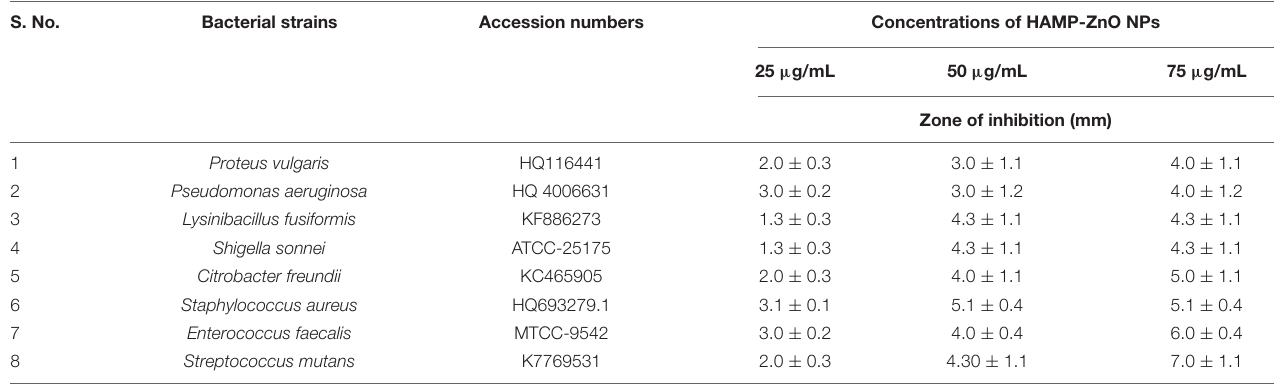
FIGURE 7 | (A) depicts a zone of inhibition of HAMP-ZnO NPs against Gram positive ( Staphylococcus aureus, Streptococcus mutans , Enterococcus faecalis and Lysinibacillu, fusiformis ) and Gram-negative bacteria ( Shigella sonnei , Pseudomonas aeruginosa , Proteus vulgaris and Citrobacter freundii). (B) shows a zone of inhibition of the 14 kDa protein of HAMPs against Pseudomonas aeruginosa . TABLE 1 | The zone of inhibition (mm) of HAMP-ZnO NPs against pathogenic bacteria viz. C. freundii, E. faecalis, L. fusiformis, P. aeruginosa, P. vulgaris S. aureus, S. mutans, S. sonnei are detailed. S. No. Bacterial